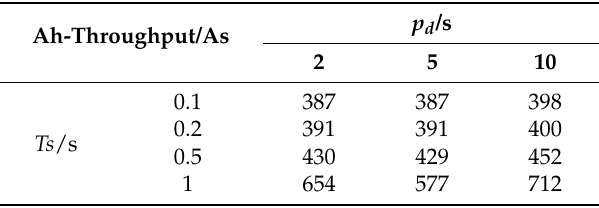
Table 3. Influence of sample time and prediction duration.